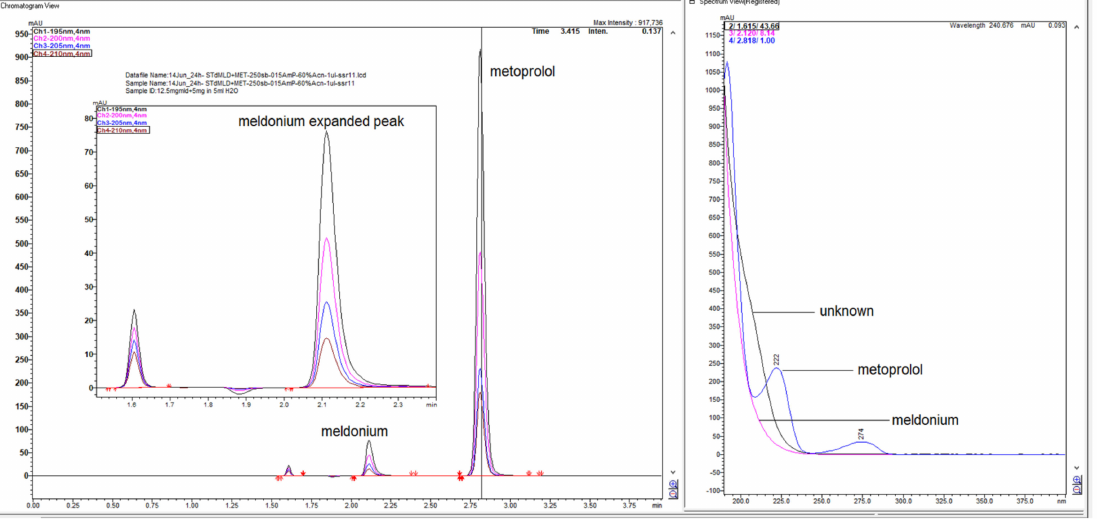
Figure 30. Chromatograms with Zorbax CN-SB-250 × 4.6 mm, gained with organic solvent ACN in mobile phase to 60% with 40% 13 mM NH 4 H 2 PO 4 .